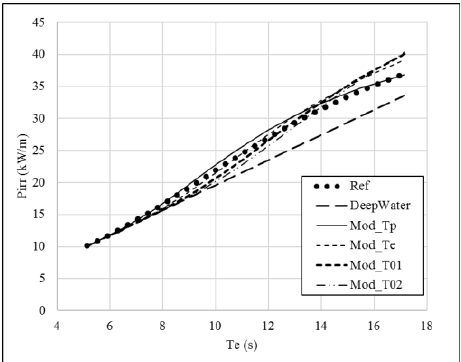
Figure 6. Modifications of the wave energy assessments using different characteristic periods ( h = 50 m).